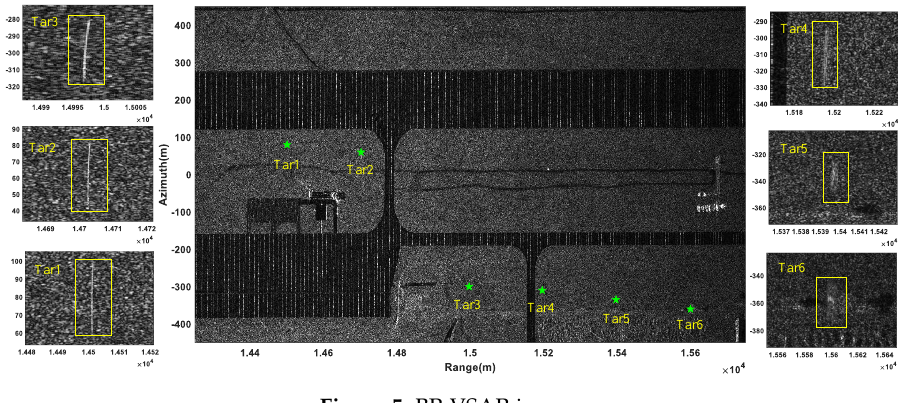
Figure 5. BP-VSAR image.